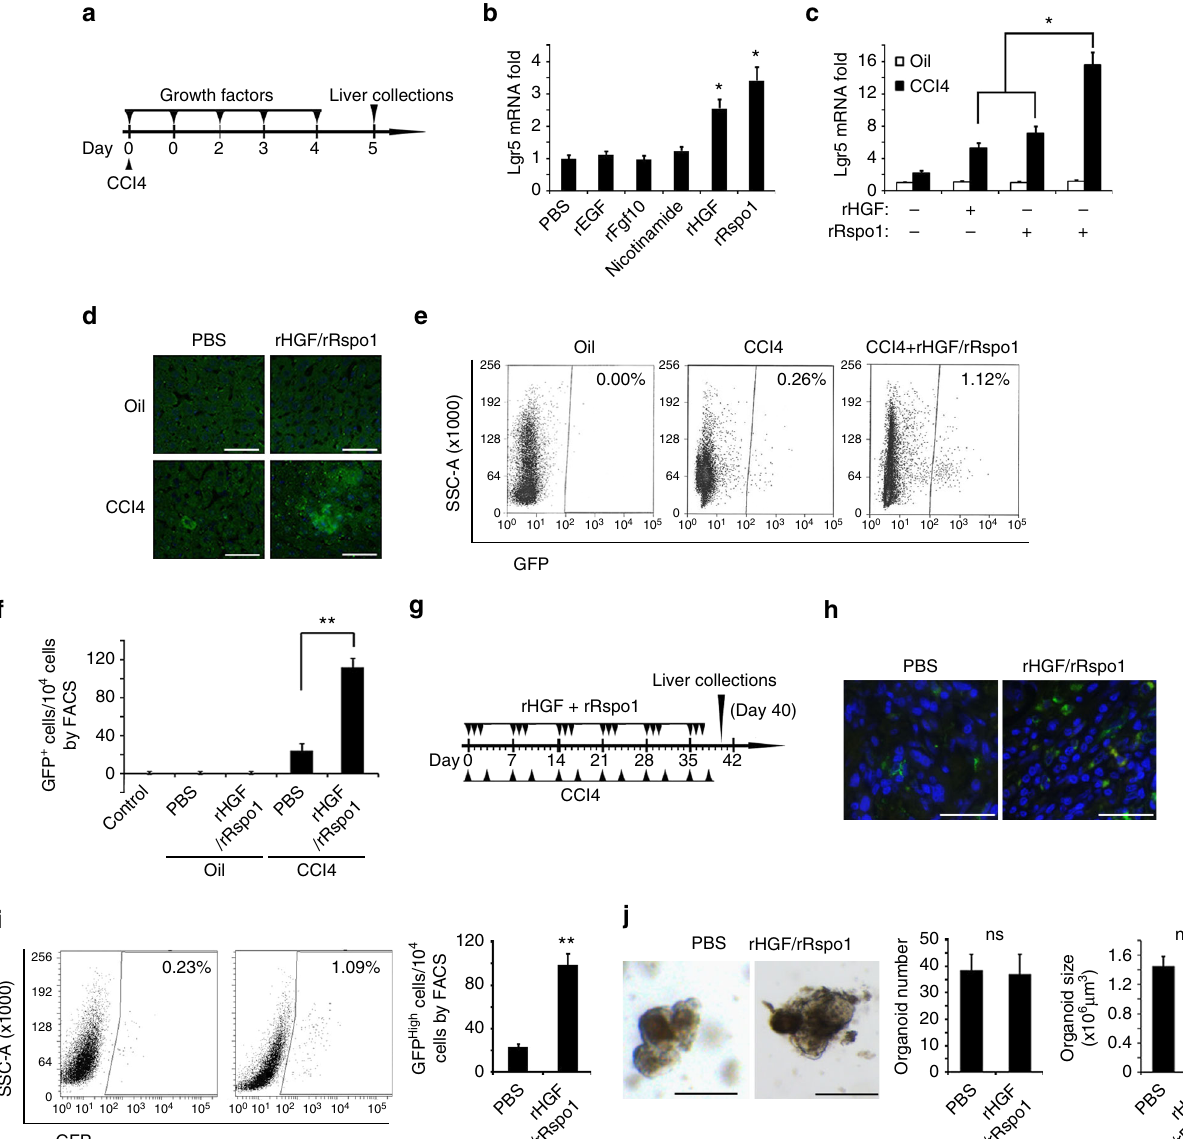
Fig. 3 rHGF/rRspo1 induces Lgr5 + liver stem cells upon CCL4 damage. a Schematic outline upon 1XCCL4 damage for b – f . b , c The Lgr5 expression was measured by qRT-PCR analysis using Lgr5 primer. Eight-week-old C57BL/J mice were injected with CCL4 and different growth factors (0.1 μ g/mice/time), as indicated in a , and the livers were harvested and analyzed. d – f Eight-week-old Lgr5-GFP mice were injected with CCL4 and rHGF or/and rRspo1 proteins (0.1 μ g/mice/time), as indicated in a , Lgr5 expression was measured using an immuno fl uorescent assay with anti-GFP antibody ( d ), Lgr5 + cell numbers were analyzed by FACS assay e , f . g . Schematic outline upon chronic CCL4 damage for h – j . h , i Eight-week-old Lgr5-GFP mice were injected with CCL4 and rHGF or/and rRspo1 proteins (0.1 μ g/mice/time), as indicated in g , and Lgr5 expression was measured using an immuno fl uorescent assay with anti-GFP antibody on day 40 ( h ), Lgr5 + cell numbers were analyzed by FACS assay i . j , single Lgr5 + liver stem cells were isolated from liver fi brosis model with rHGF plus rRspo1 treatment described as g on day 40 (rHGF/rRspo1) or from 1XCCl4-injured liver treated with PBS on day 5 (PBS), which was cultured to grow into organoids. The represented organoid pictures were shown, and the organoids number and organoids size were analyzed. For b and c , n = 5 mice/ group. Scale bars, 200 μ m ( d , g ). For b , c , triplicates for each condition were analyzed. The results are shown as mean ± s.d. of three independent experiments. * p < 0.05. For f , i , j , the results are shown as mean ± s.d. of three independent experiments. ** p < the in vitro intestine organoid culture factors, Rspo1 and Slit2, induced Lgr5 + intestine stem cells in vivo 16 . Therefore, we then tested whether the growth factors involved in the Lgr5 + liver stem cells culture medium in vitro induced the Lgr5 + liver stem cells in vivo. For this purpose, recombinant His-tagged EGF, Fgf10, HGF, and Rspo1 (rEGF, rFgf10, rHGF, and rRspo1) were pro- duced (Supplementary Fig. 13). Eight-week-old Lgr5-GFP mice were injected with a single dose of CCL4 at day 0, the growth factors (0.1 μ g per mice and once per day) were injected into the